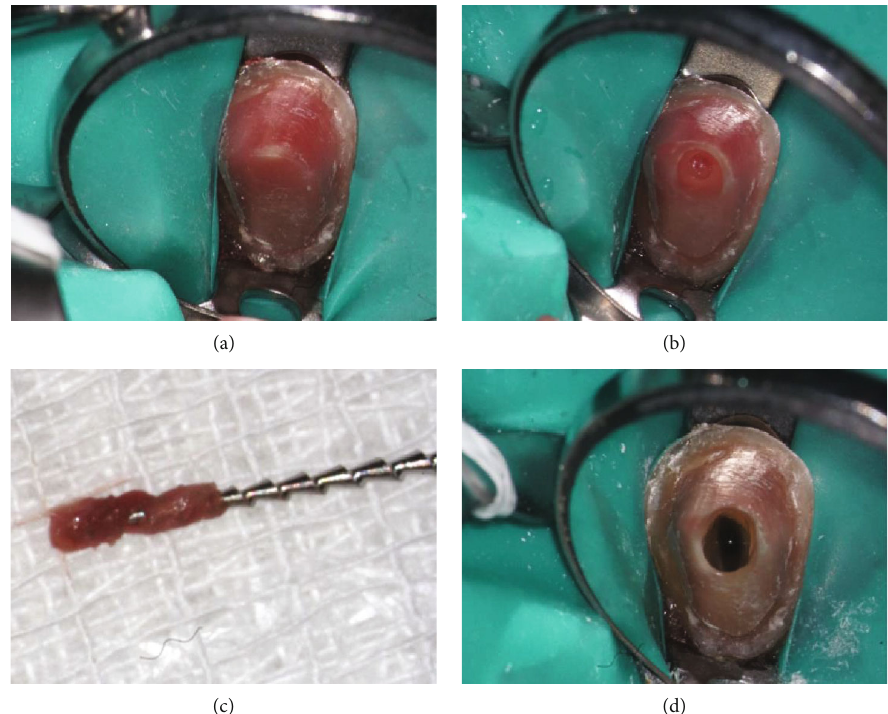
Figure 2: (a) Rubber dam isolation of tooth #11. (b) Initial access preparation showing hemorrhagic pulpal tissue. (c) Extirpated pulpal tissue on hedstrom fi le. (d) Irrigation with 6% sodium hypochlorite solution in a pulp chamber. Tooth immediately changed color due to oxidation of